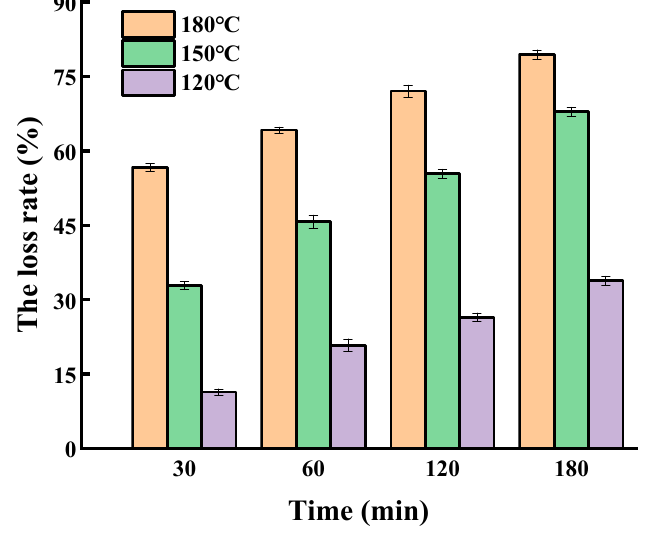
Figure 4. The loss rate of soybean germ phytosterols in lard.